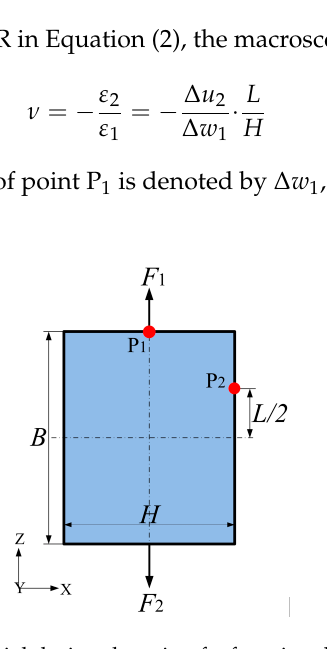
Figure 2. Initial design domain of a functional element.